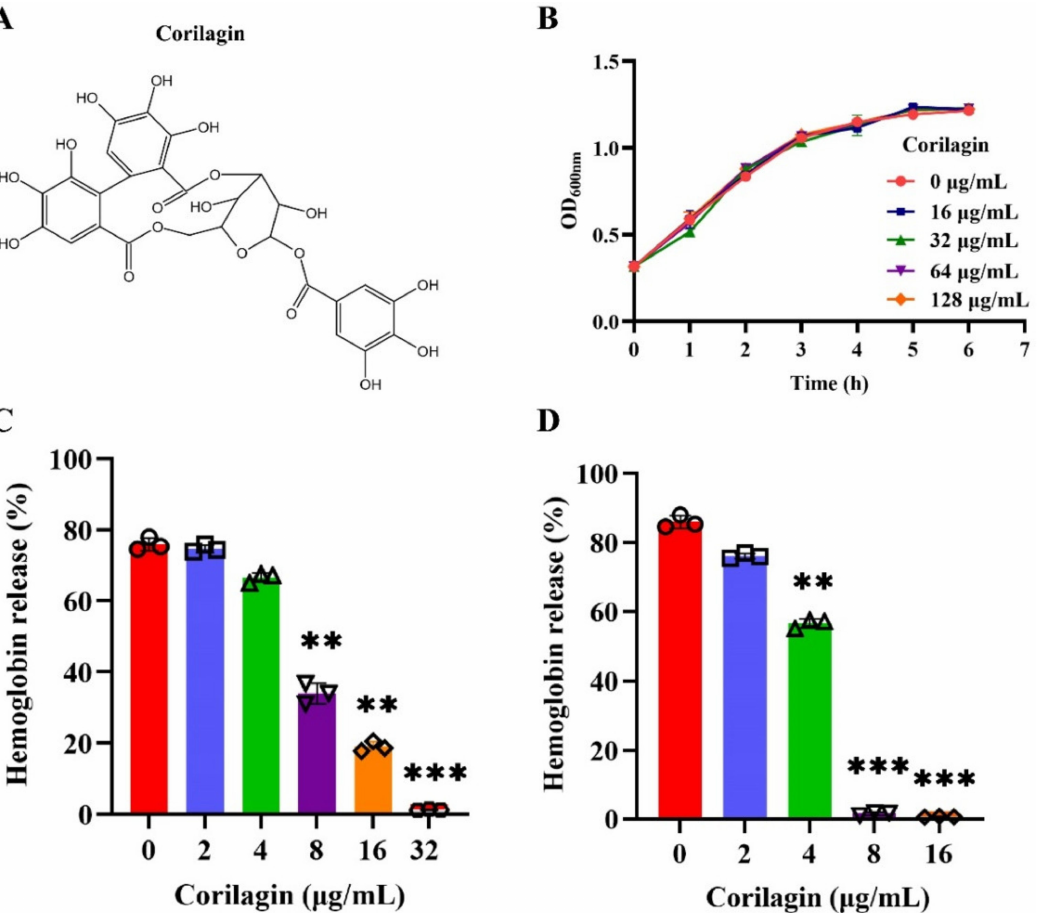
Figure 1. Corilagin restrained the hemolytic efficacy of PLY. ( A ) The chemical structure of corilagin. ( B ) Growth curve of S. pneumoniae challenged with corilagin at different concentrations (0, 16, 32, 64 and 128 µ g/mL). The efficacy of corilagin against the hemolysis both in S. pneumoniae supernatants ( C ) and purified PLY ( D ), ** p < 0.01, *** p <